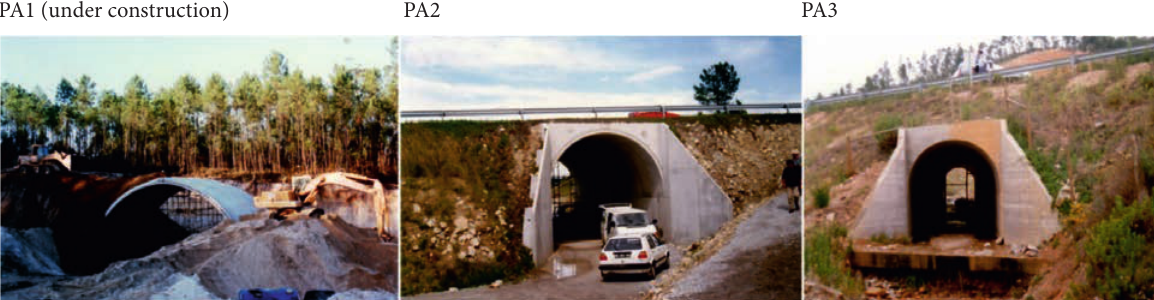
Fig. 1. Views of the three types of underpasses studied